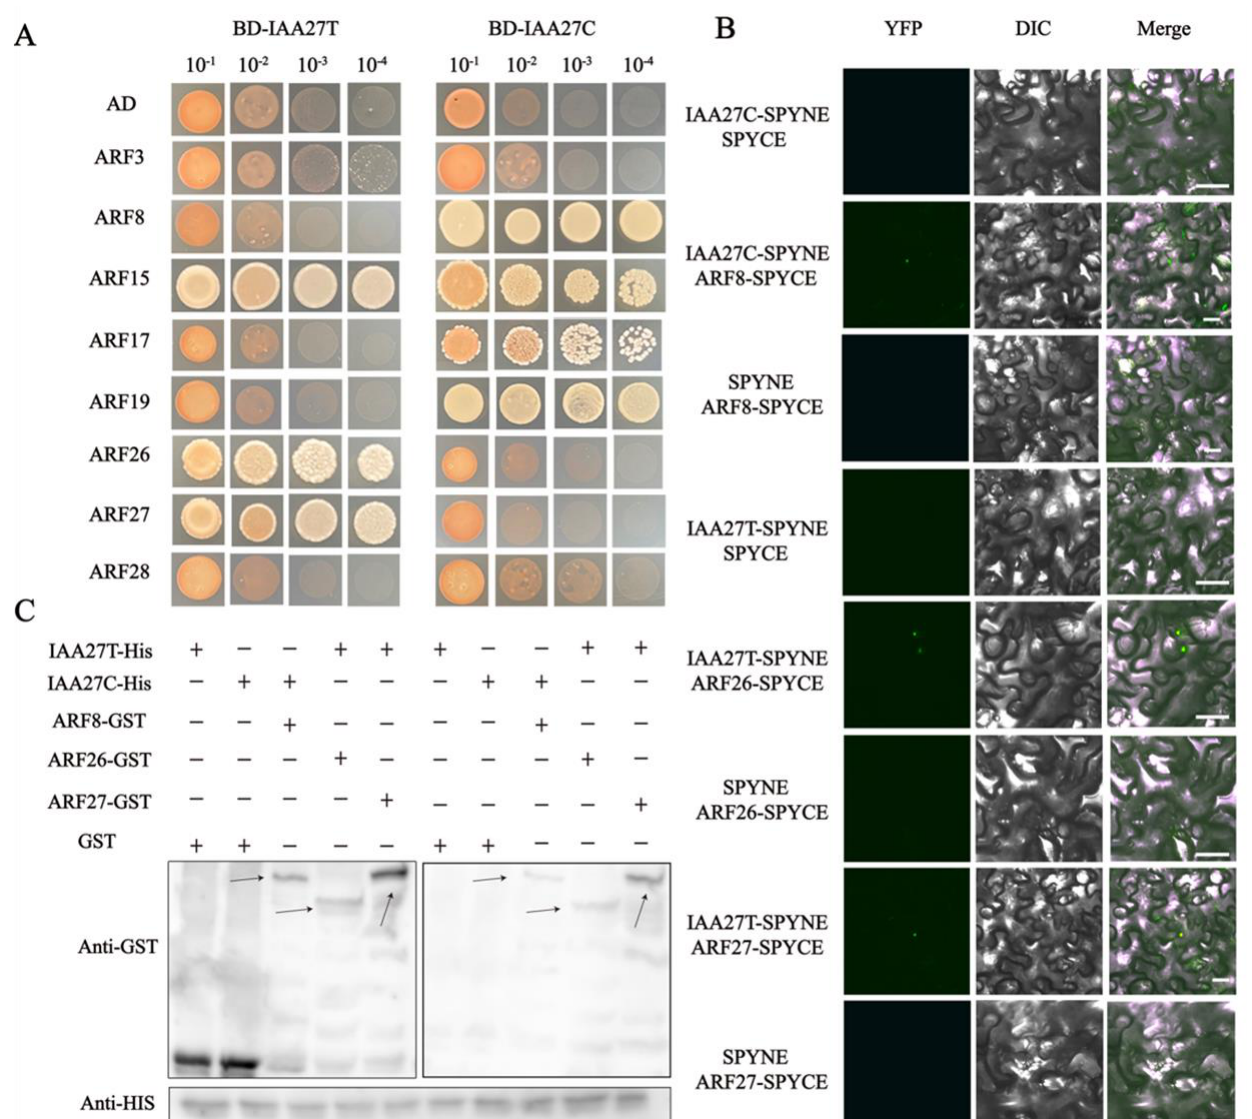
Figure 7. MdIAA27 interacts with MdARFs, which was identified by Y2H, BiFC, and pull − down assays. ( A ) Interaction between MdIAA27 and MdARFs in a Y2H assay. The ability of yeast cells to grow on synthetic medium lacking tryptophan, leucine, histidine, and adenine was scored as positive interaction. ( B ) Interaction between MdIAA27 and MdARFs as determined using a BiFC assay. MdIAA27 − SPYNE and MdARFs − SPYCE were performed for the interaction assay. MdIAA27 − SPYNE + SPYCE and SPYNE + MdARFs − SPYCE were used as negative controls.